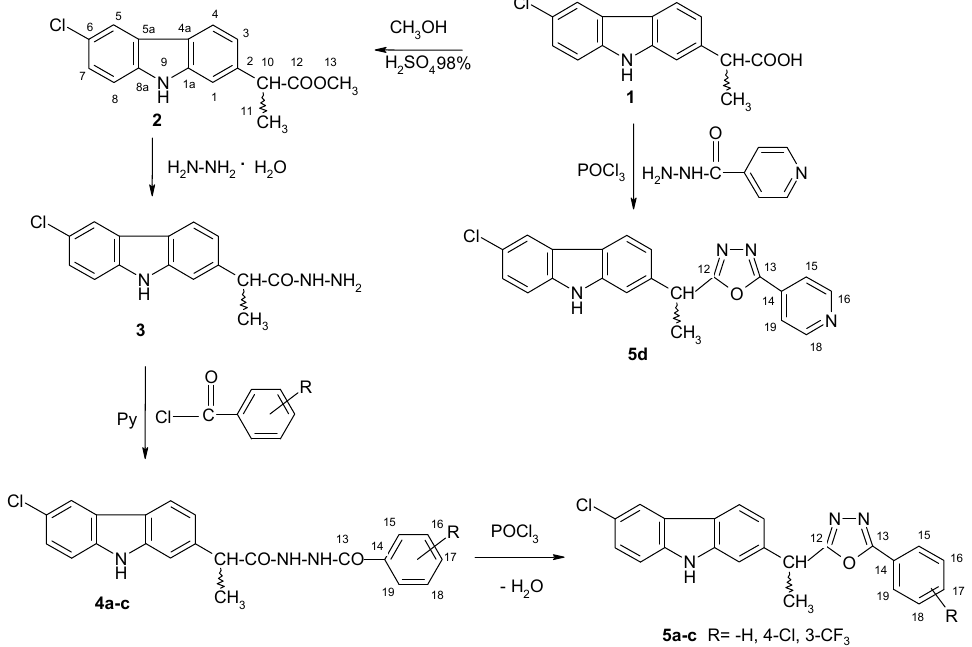
Figure 2. 1,3,4-Oxadiazole derivatives used as